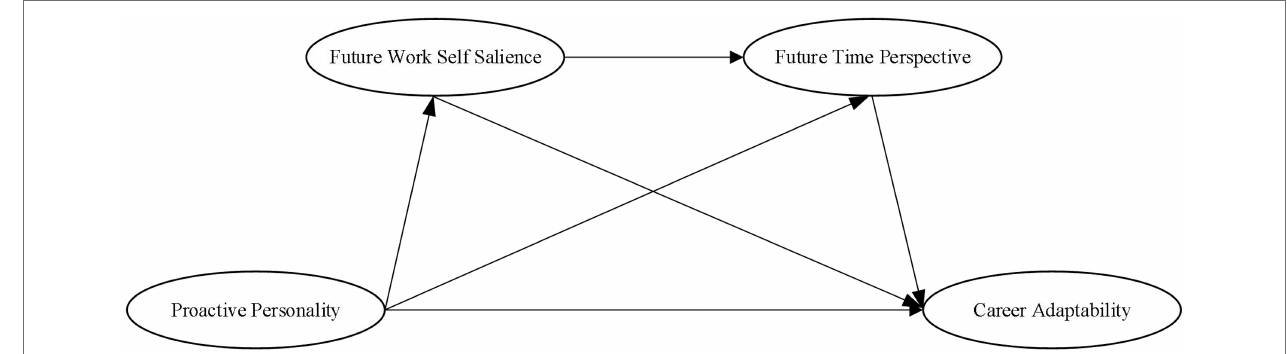
FIGURE 1 | The research model.